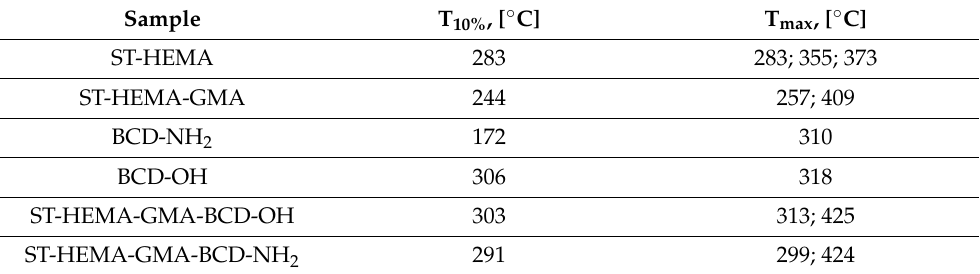
T 10% = decomposition onset temperature (measured at 10% weight loss); T max = the maximum decomposition temperature, corresponding to the maximum of DTG peak (the first derivative of the thermogravimetric